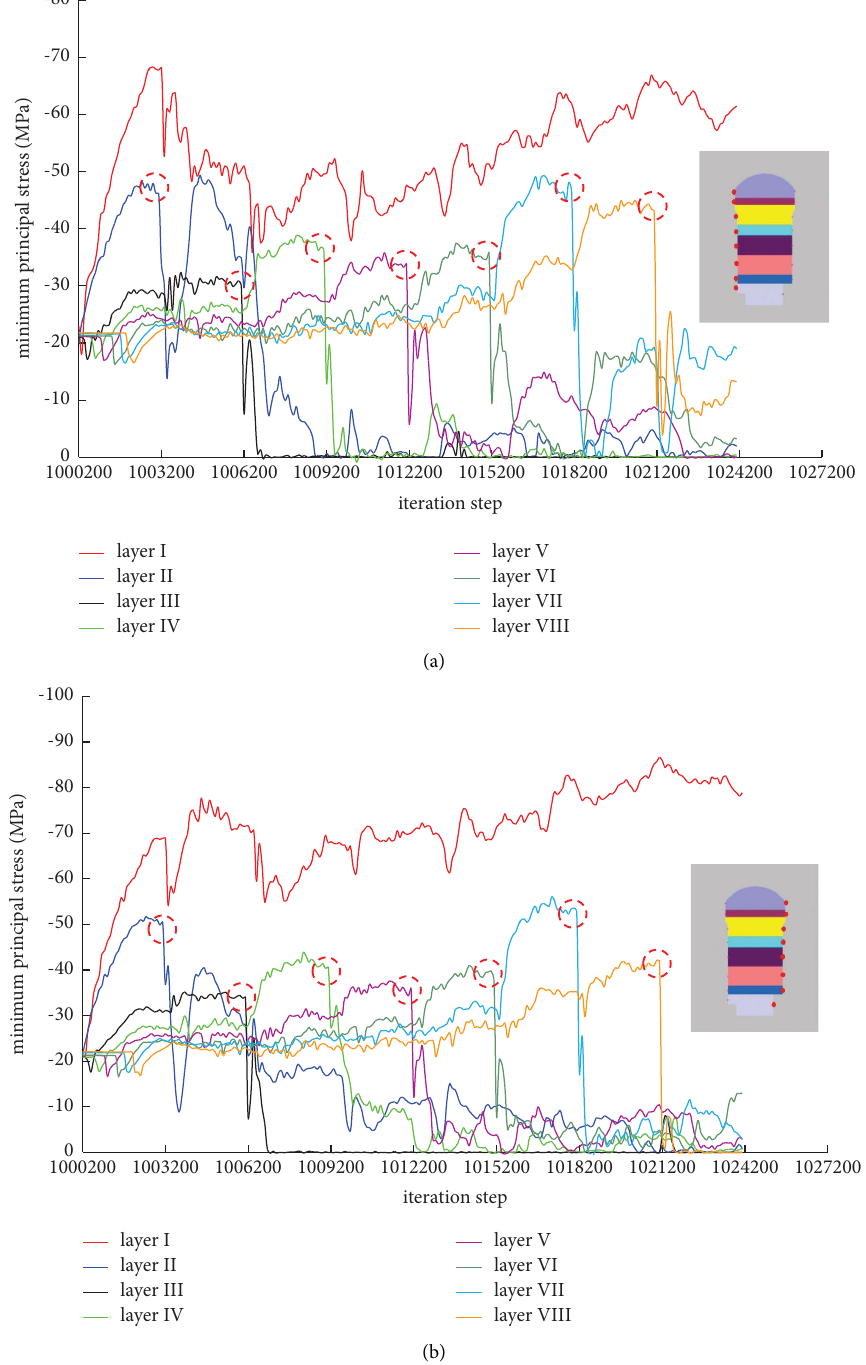
Figure 8: Te minimum principal stress curve of characteristic points at (a) left and (b) right side